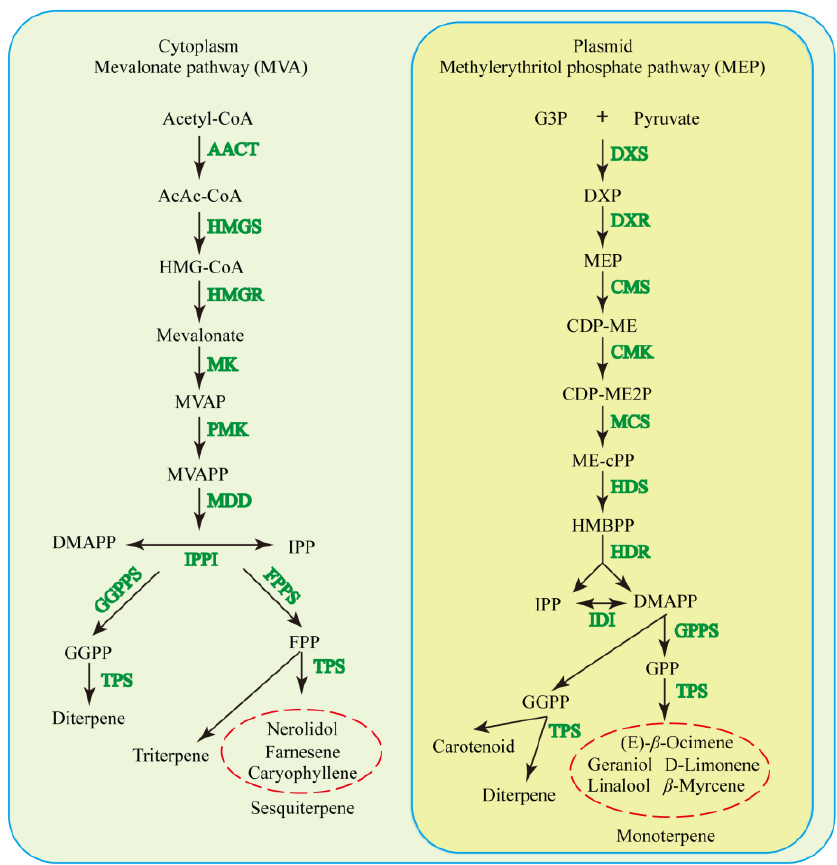
Figure 2. Terpenoid biosynthesis pathways in plants. MVA, mevalonic acid; AACT, acetyl-CoA acetyltransferase; HMG, 3-hy-droxy-3-methylglutaryl-CoA; HMGS, hydroxy methylglutaryl-CoA synthase; HMGR, hydroxy methylglutaryl-CoA reductase; MK, mevalonate kinase; MVAP, mevalonate-5-phosphate; PMK, phosphomevalonate kinase; MVAPP, mevalonate-5-diphosphate; MDD, mevalonate-5-diphosphate decarboxylase; IPP, isopentenyl diphosphate; IPPI, isopentenyl diphosphate isomerase; DMAPP, dimethylallyl pyrophosphate; GGPPS, GGPP synthase; FPPS, farne- syl pyrophosphate synthase; FPP, farnesyl pyrophosphate; GGPP, geranylgeranyl